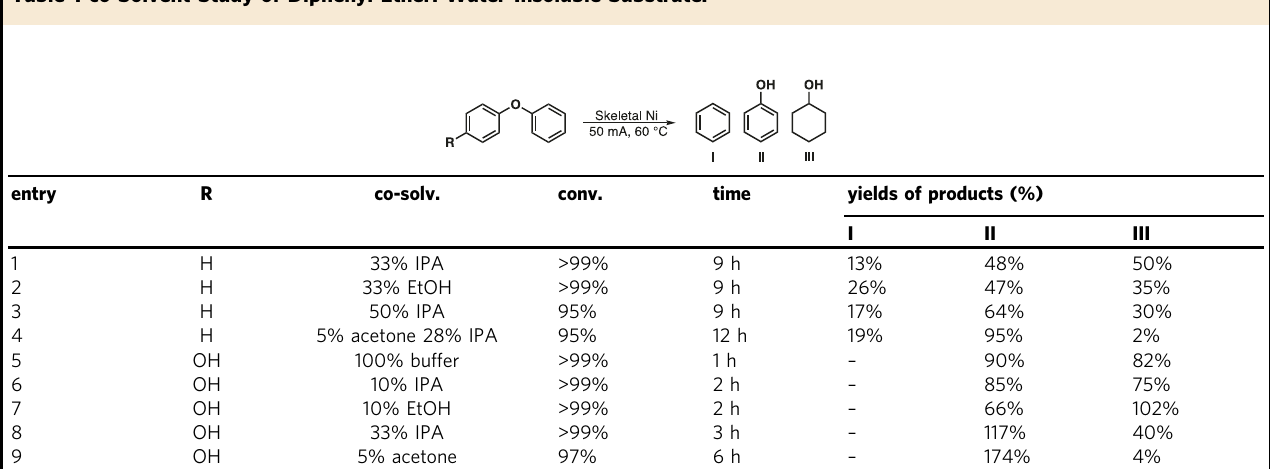
Table 1 co-Solvent Study of Diphenyl Ether: Water Insoluble Substrate.